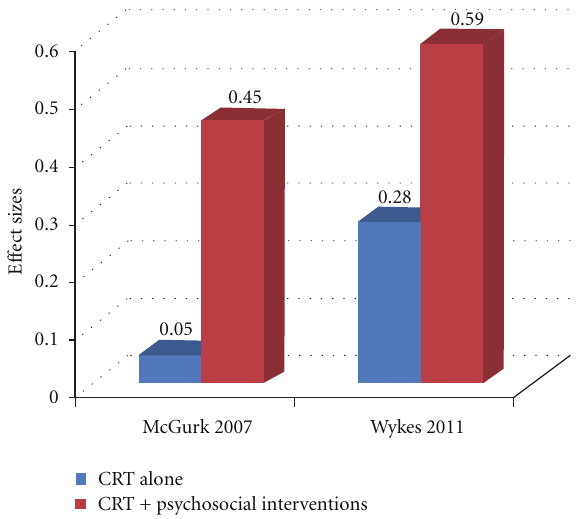
Figure 1: E ff ect sizes (Cohen’s d) of cognitive remediation on func- tioning. Data from the meta-analytic studies by McGurk et al. [1] and Wykes et al. [2]. CRT: cognitive remediation